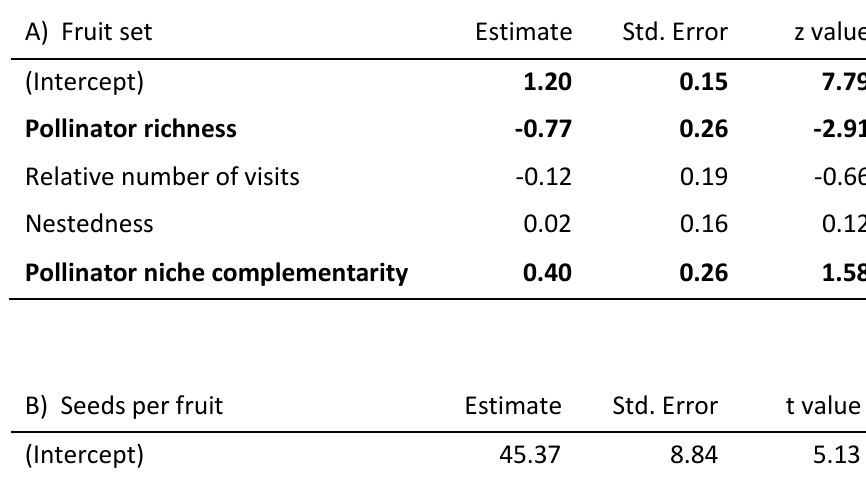
Table 2. Results of GLM showing associations between simple visitation and network structure metrics and A) site-level average fruit set and B) site-level average number of seeds per fruit based on best model selected. Bold letters indicate variables with large effects.